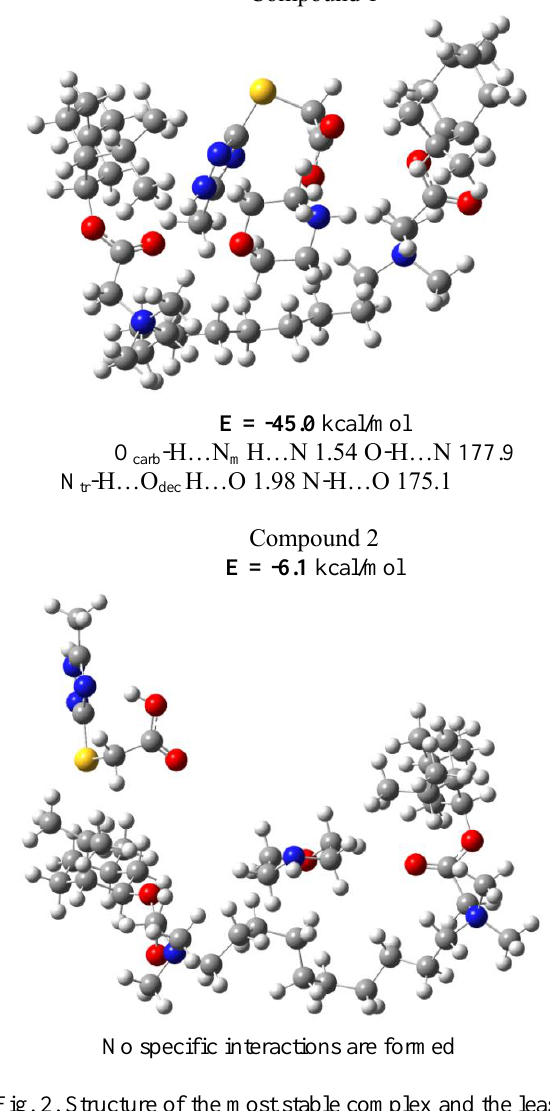
Fig. 2. Structure of the most stable complex and the least stable complex of thiotriazoline with decamethoxin, their interaction energy in the complex (E , kcal/mol), and int characteristics of the hydrogen bonds (H...A, Å, and D- H...A, deg.) according to B97-D3/